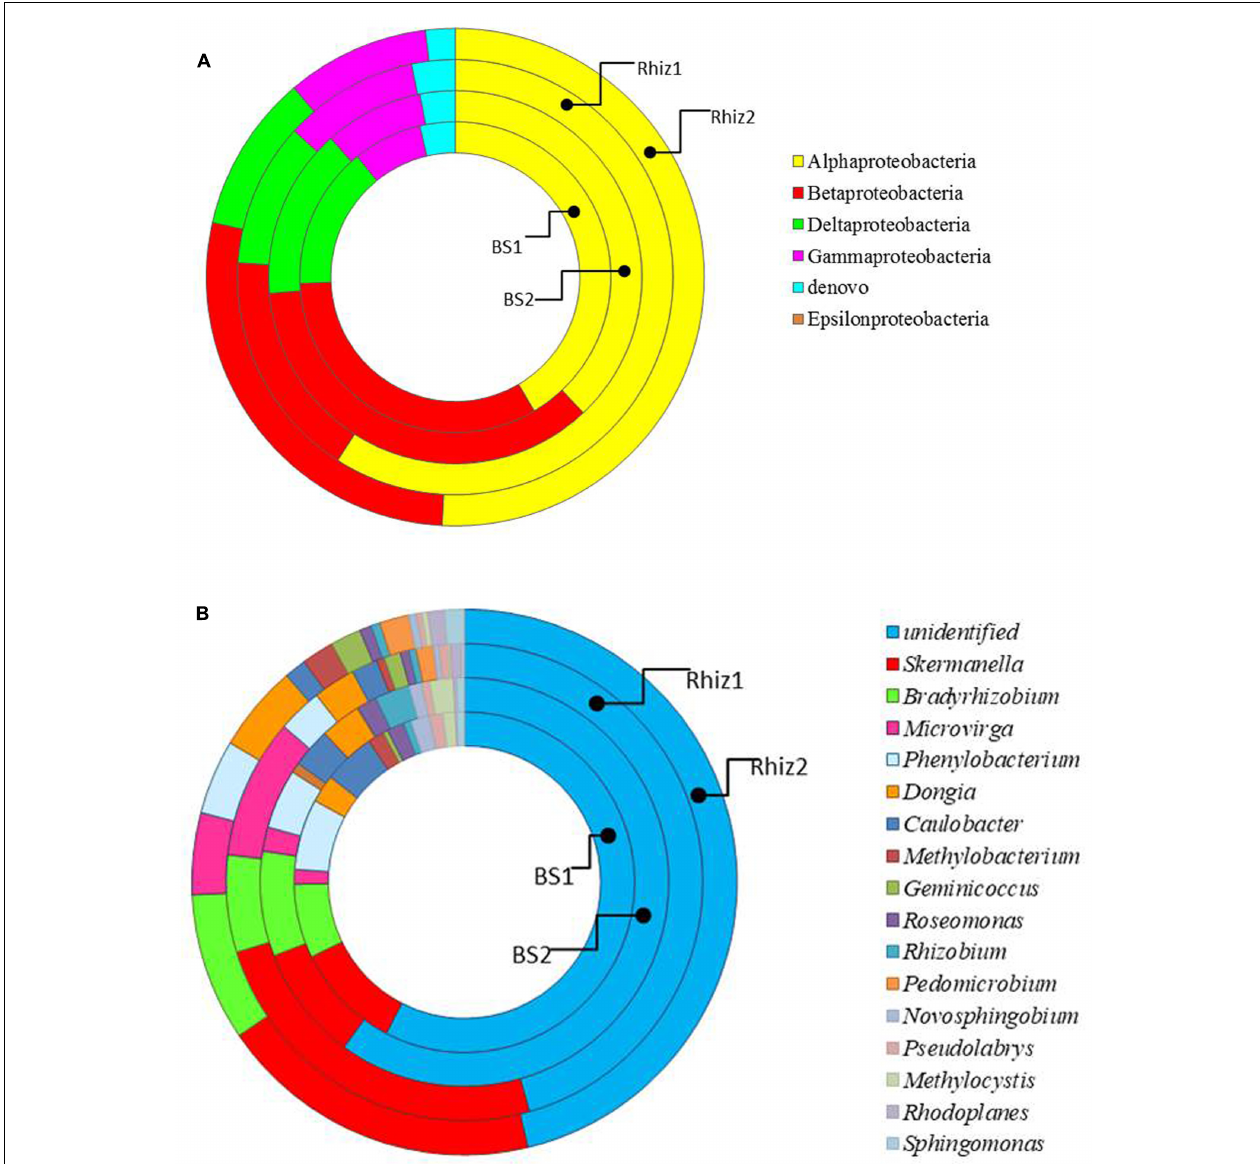
FIGURE 6 | Distribution of the (A) phylum Proteobacteria and (B) genera belonging to alpha Proteobacteria in the different classes in bulk soil and rhizosphere of V. vinifera cv. Pinot Noir during the two sampling dates (flowering and early fruiting). From the center to the edge BS1, BS2, Rhiz1, Rhiz2.